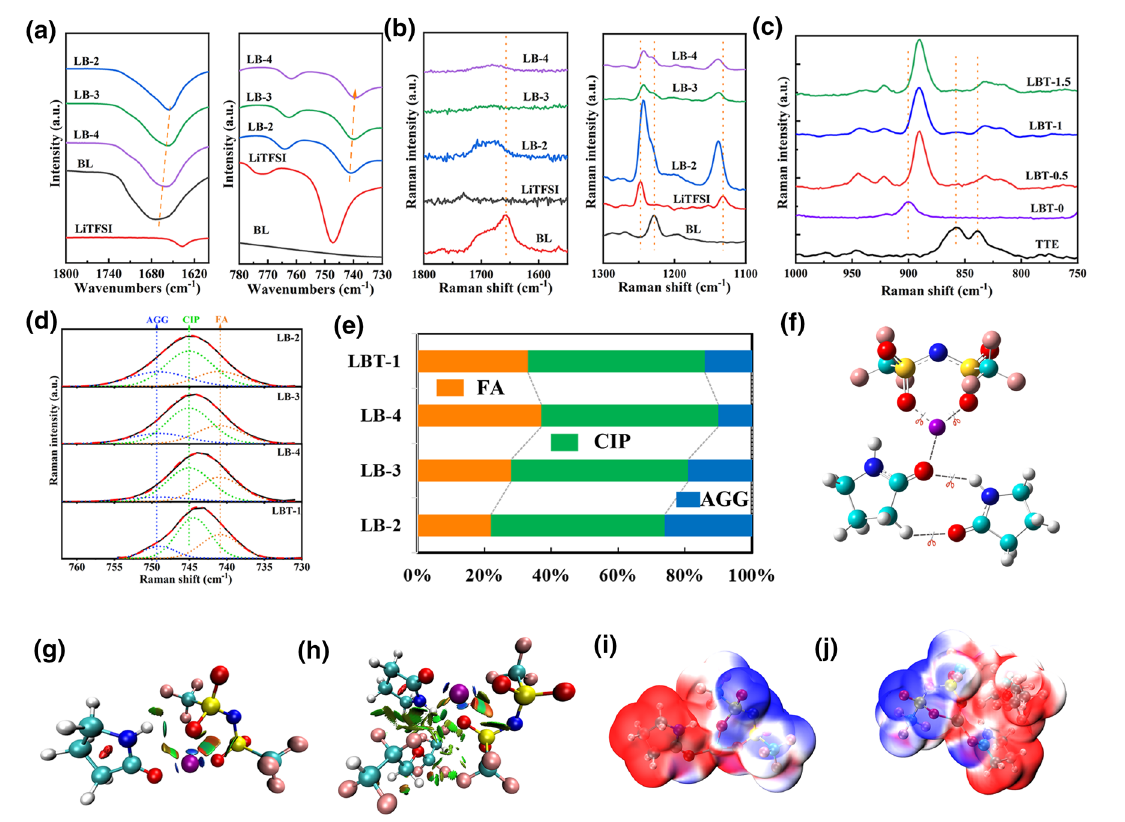
Fig. 1 a FTIR spectra of LB electrolytes at different compositions. Raman spectra of b LB electrolytes and c LBT electrolytes at different compositions. d Fitted Raman spectra of LB electrolytes and LBT-1 in the range of 730–760 cm −1 . The experimental spectra and fitted curves are denoted by the solid and dashed lines, respectively. e Solvate species distribution in LB electrolytes and LBT-1 determined by fitted Raman spectra. f Schematic diagram of LiTFSI and BL forming a liquid. Gradient isosurfaces (s = 0.5 au) for i LiTFSI-BL and j LiTFSI-BL-TTE. ESPs mapped on electron total density for k LiTFSI-BL and l